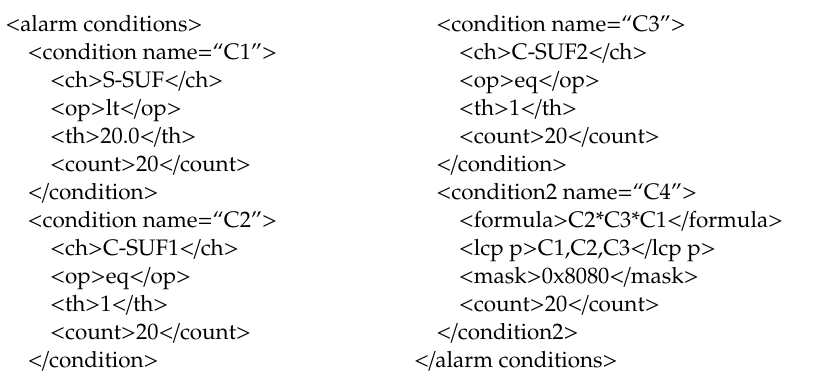
Table 7. Example of a second-order alarm condition in XML format.